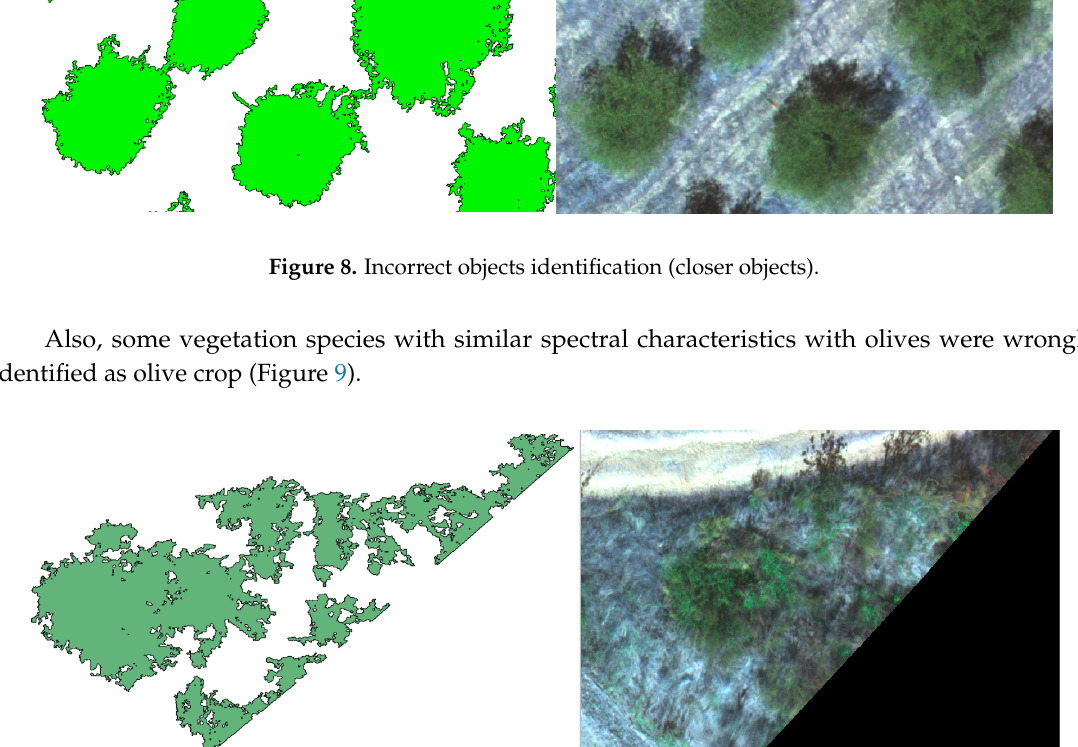
Figure 9. Incorrect objects identification (other type of vegetation).